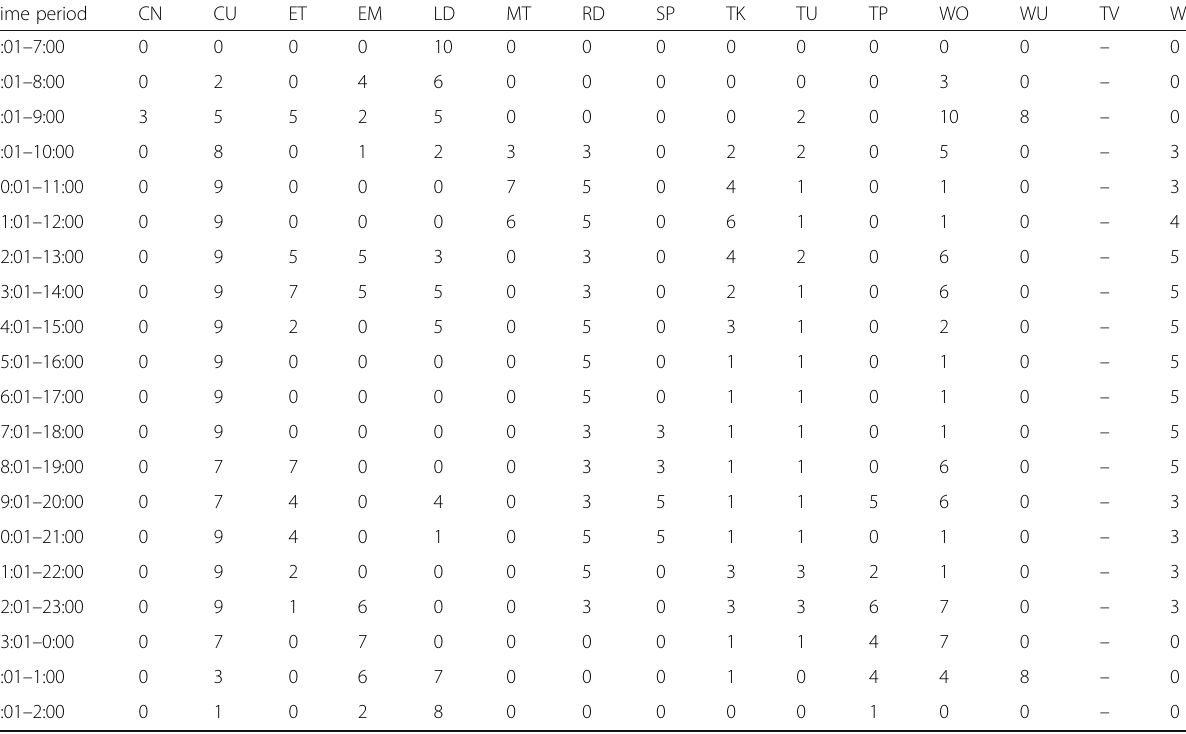
Table 17 Time – activity table for Tuesday (on this day a regular meeting present) for eButton wearer 2 Time period